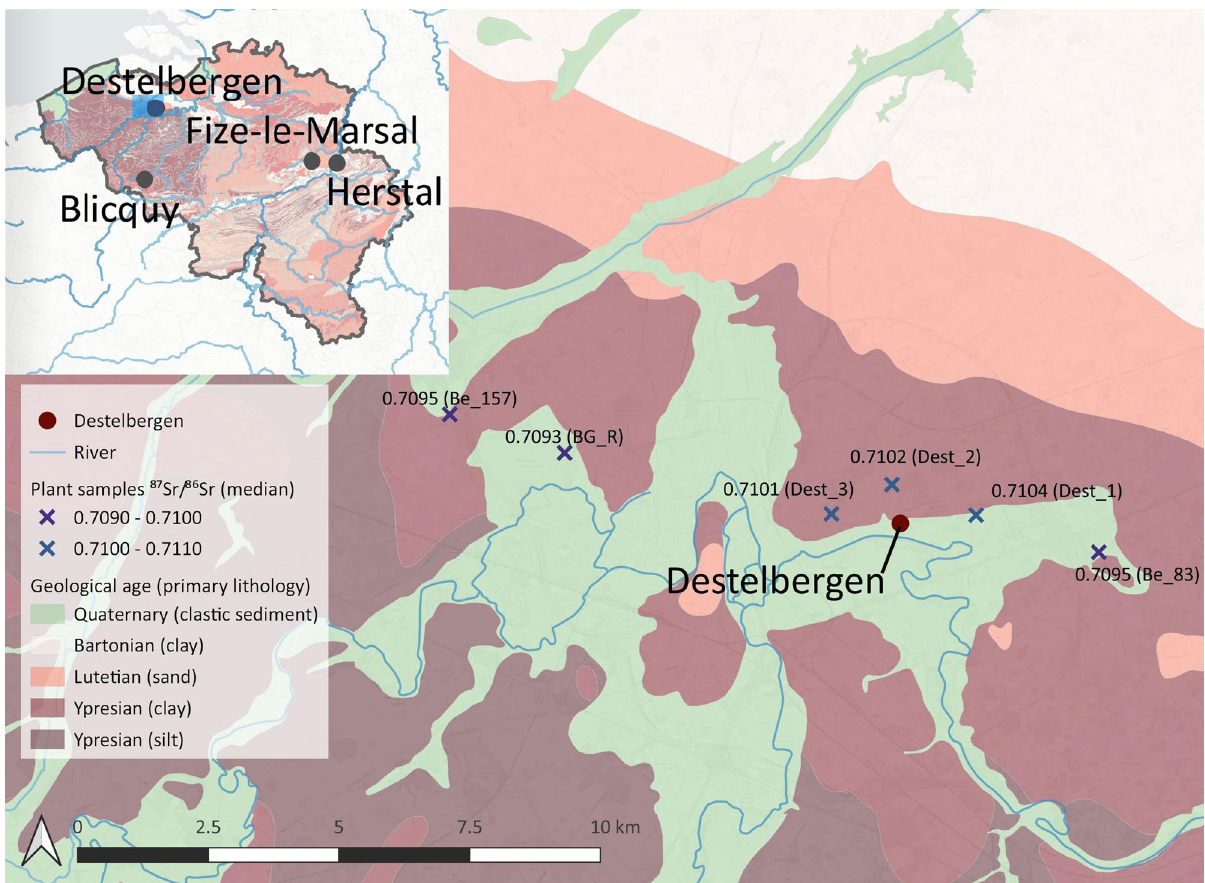
Figure 1. Location of the Destelbergen, Blicquy, Fize-le-Marsal and Herstal sites within Belgium on the inset map and the six new plant sampling locations around Destelbergen with median 87 Sr/ 86 Sr superimposed on a geological map (map created using QGIS version 3.12.0-Bucure ș ti, https:// qgis. results 8 . The cemetery Fize-le-Marsal “Beauflot-Pivache” revealed Gallo-Roman burials on which new analyses were performed. For more information on the sites, see Suppl. Text 1. Sufficient evidence shows that in western Europe the Iron Age diet was fairly homogeneous, rich in animal protein in the form of meat and dairy and almost exclusively terrestrial e.g.: 9–11 . Although, for Belgium, clear archaeozoological and archaeobotanical evidence on Iron Age food economies is scarce, data from neighbour- ing areas indicates that the population relied mainly on varying proportions of cattle, sheep, and pig as main suppliers of animal protein, and cereal and, to a lesser extent, pulses as a staple food 10,12,13 . A total lack of fish bone at Iron Age sites led to the conclusion that fish was not consumed in Belgium, nor in England, but was yet present in some areas such as in Scotland and the Netherlands 14 . Generally, wild resources, such as game and fish, were not prominent in the protohistoric diet in western Europe 12 and are even suggested to have been taboo 14 .